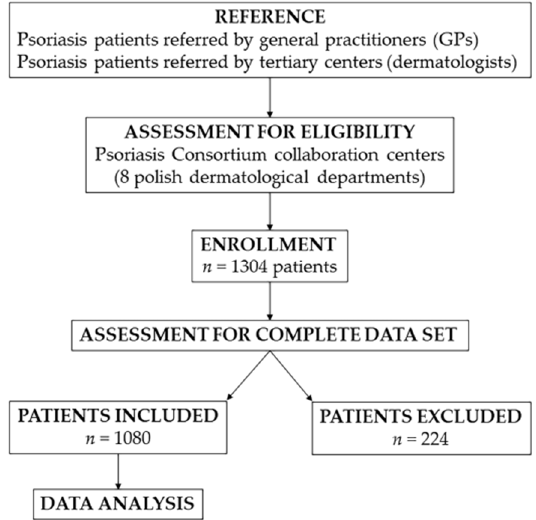
Figure 1. The consort diagram.